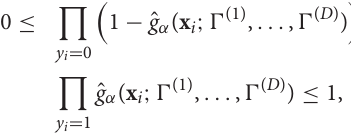
destroys the rank-three structure of Equation (19). Yet, an R (cid:12) (cid:12) (cid:12) (cid:12)(cid:12) (cid:12) (cid:12) (cid:12) (cid:12) (cid:12) (cid:12) (cid:12)